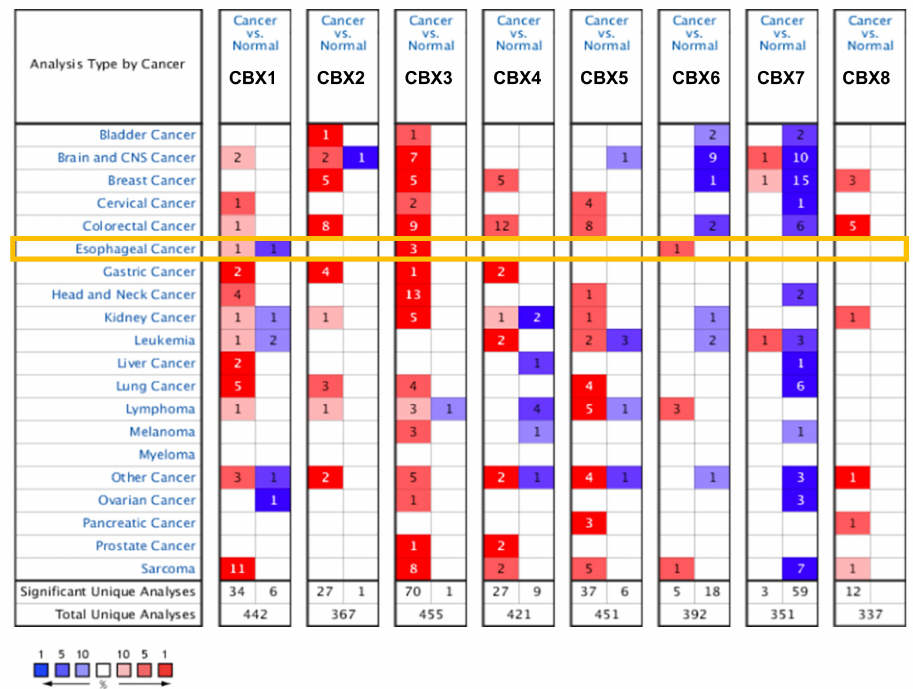
Figure 1. Transcriptional expression of CBX family proteins in 20 types of cancers from Oncomine. As shown in the orange frame, CBX3 and CBX6 were significantly upregulated in EC tissues compared to normal tissues. The number in the graphic represents the numbers of datasets with statistically signifi- cant changes in the mRNA expression of the target gene: upregulated (red) and downregulated (blue), and the darker the color, the higher or lower the expression. The criteria used was as follows: p -value: 0.01, fold change: 2, gene rank: 10%, data type: mRNA, analysis type: cancer vs. normal tissue.